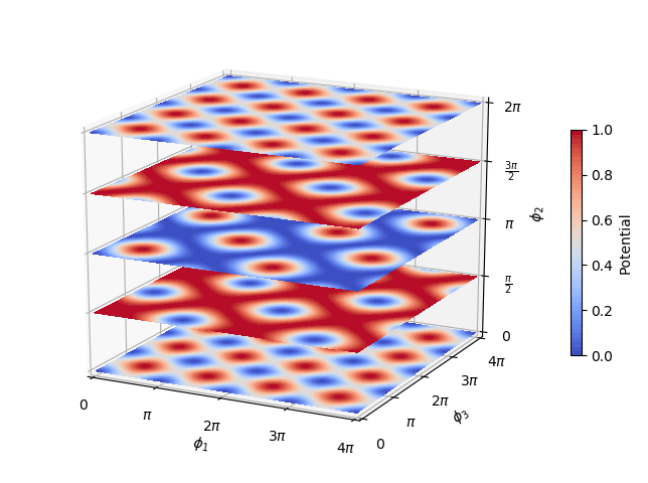
Figure 10. The potential energy density is seen in sliced planes (cid:30) 2 = n(cid:25)